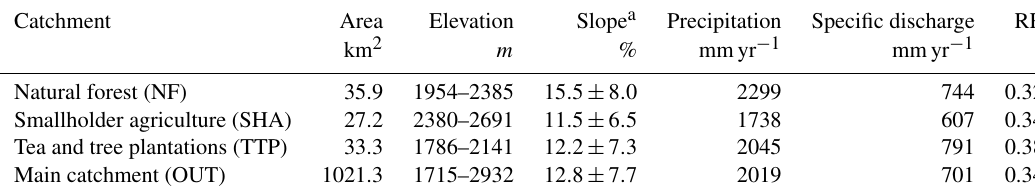
Table 1. Physical and hydroclimatic characteristics of the study catchments in the South-West Mau, Kenya. Precipitation, specific discharge and run-off ratio are presented for the study period of 15 October 2015 to 14 October 2016.